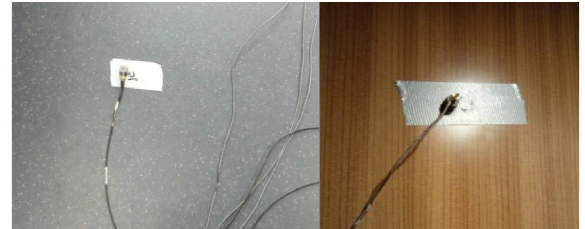
Figure 3: Local vibration measurement point diagram of foor and side wall.